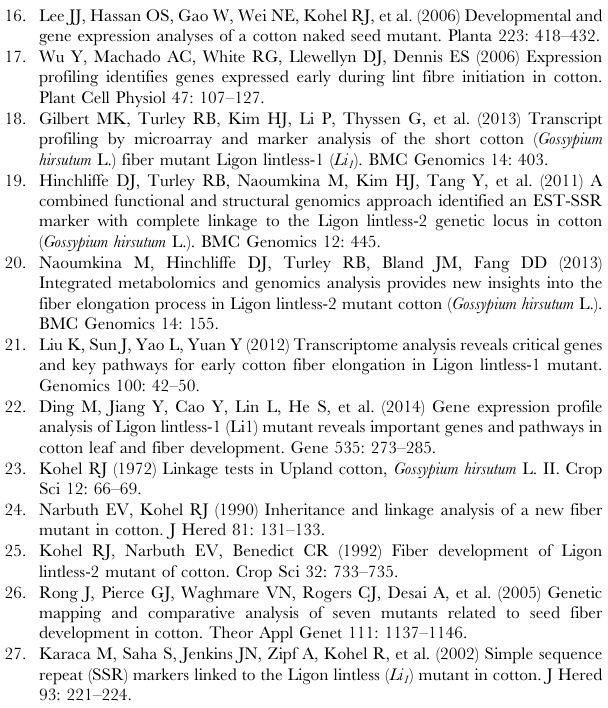
Table S1 Primer sequences used for RT-qPCR. (XLSX) Table S2 Complete results of gene ontology analysis. (XLSX) Table S3 Expression levels of probes showing altered regulation in Li 1 , Li 2 (field) and Li 2 (greenhouse) as compared to the wild type (WT). (XLSX) Table S4 Comparison between RT-qPCR and micro- array under different growing environments.